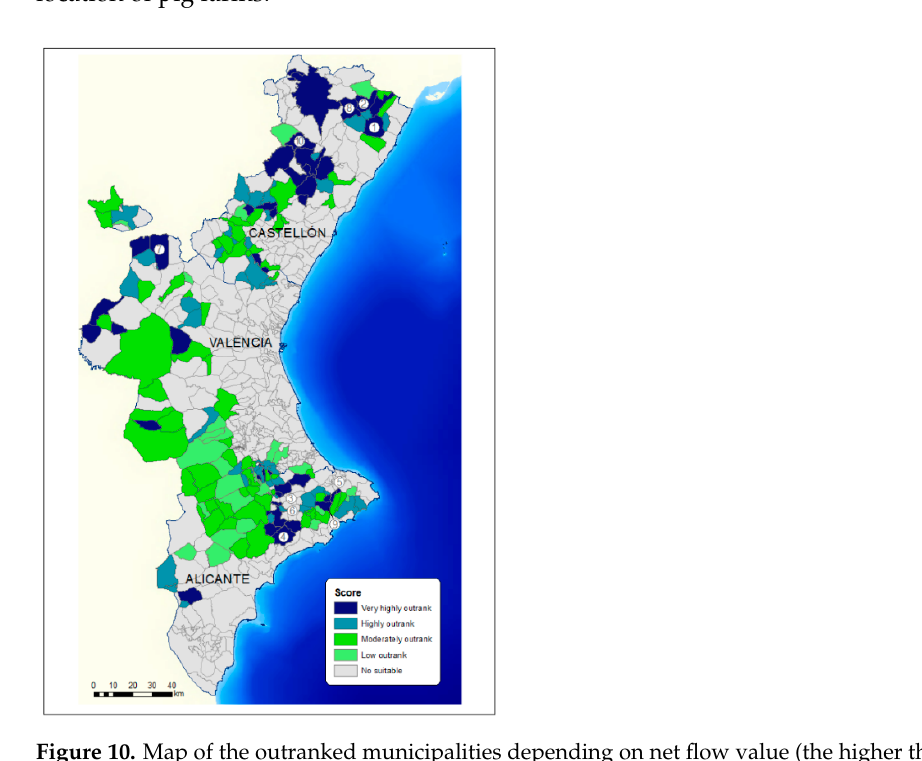
Figure 10. Map of the outranked municipalities depending on net flow value (the higher the score is the better the municipality).